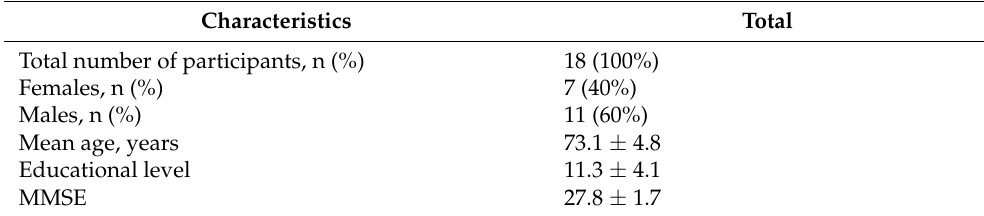
Table 2. Participants’ characteristics at baseline